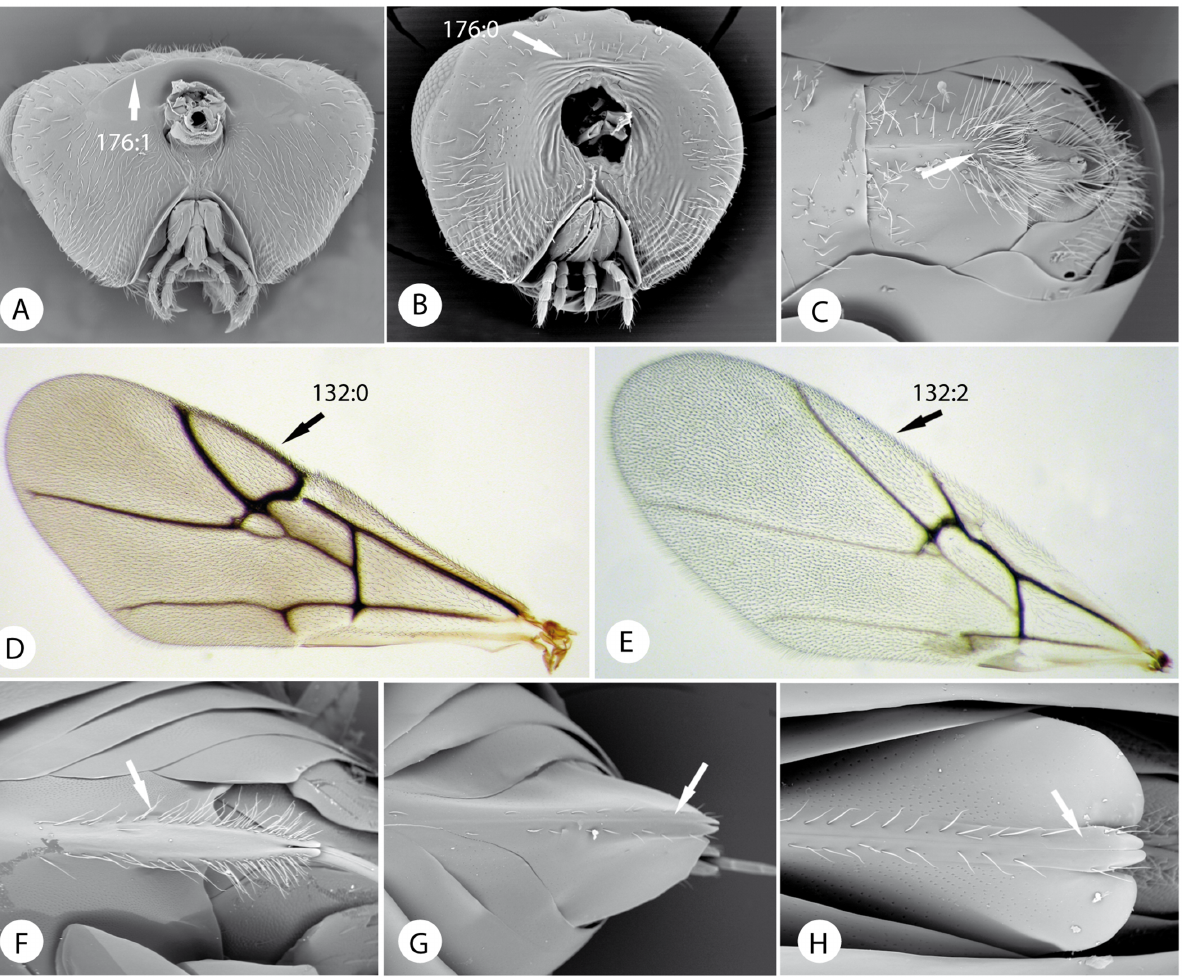
Fig 12. Morphological characters of tribes of Cynipidae. A) Qwaqwaia scolopiae Liljeblad Nieves-Aldrey & Melika, head in posterior view. B) Xestophanes potentillae (Retzius in De Geer), head in posterior view. C) hypopygium in ventral view and D) fore wing of Qwaqwaia scolopiae . E) fore wing of Plagiotrochus razeti Barbotin. F) Amphibolips castroviejoi Nives-Aldrey & Medianero, hypopygium in ventral view. G) Aulacidea hieracii (L.), hypopygium. H) Synergus ibericus Tavares, hypopygium.